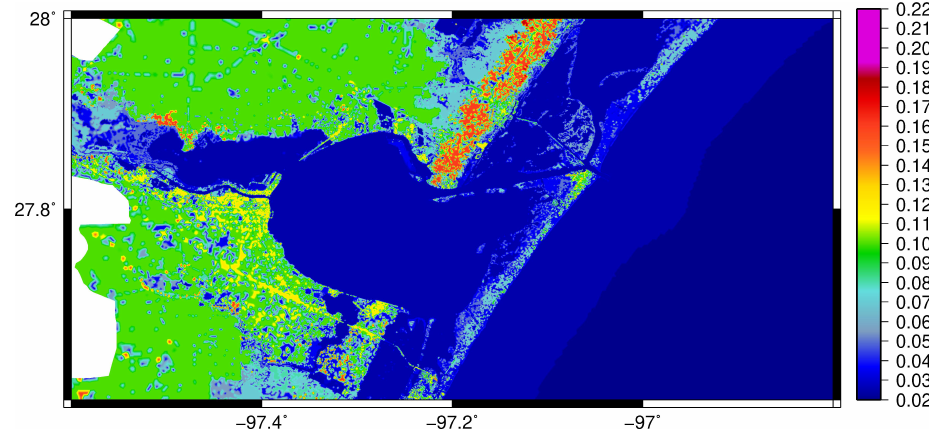
Figure 6. Manning’s n in the study